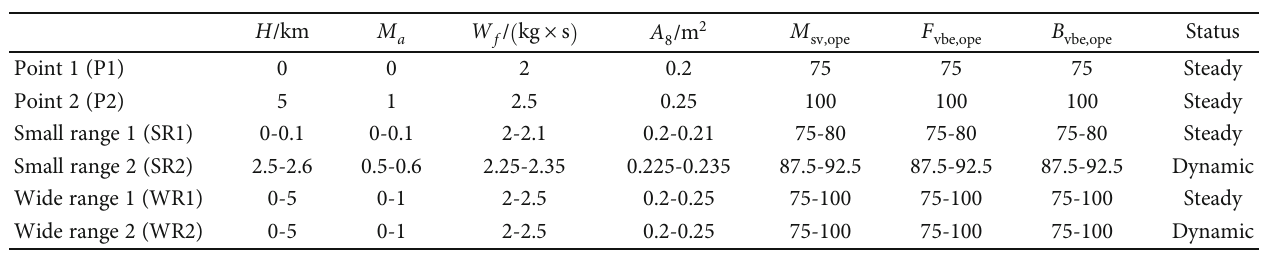
Table 5: The list of experiment